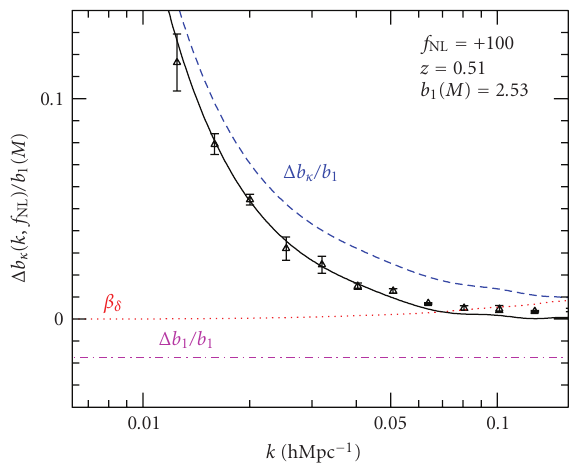
Figure 7: Non-Gaussian bias correction (filled symbols) for halos of mass M > 2 × 10 13 M (cid:14) /h extracted at z = 0 . 5 from simulations model. The solid curve represents the theoretical of the local f loc NL model (42). The dashed, dotted-dashed-dotted, and dotted curves show the scale-dependent bias Δ b κ , the scale-independent o ff set Δ b I and the contribution from the matter power spectrum b 1 ( M ) β δ that (see Figure 2). The error bars indicate the arise at first order in f loc NL scatter among 8 realizations of 1024 3 simulations with box size L = 1600h − 1